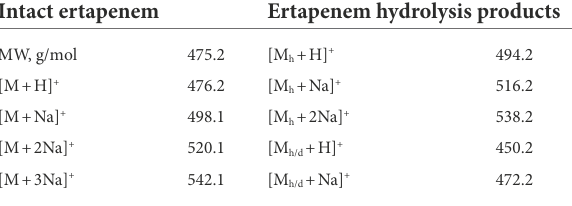
TABLE 1 Expected molecular masses of ionic forms of intact ertapenem and its hydrolysis products. Intact